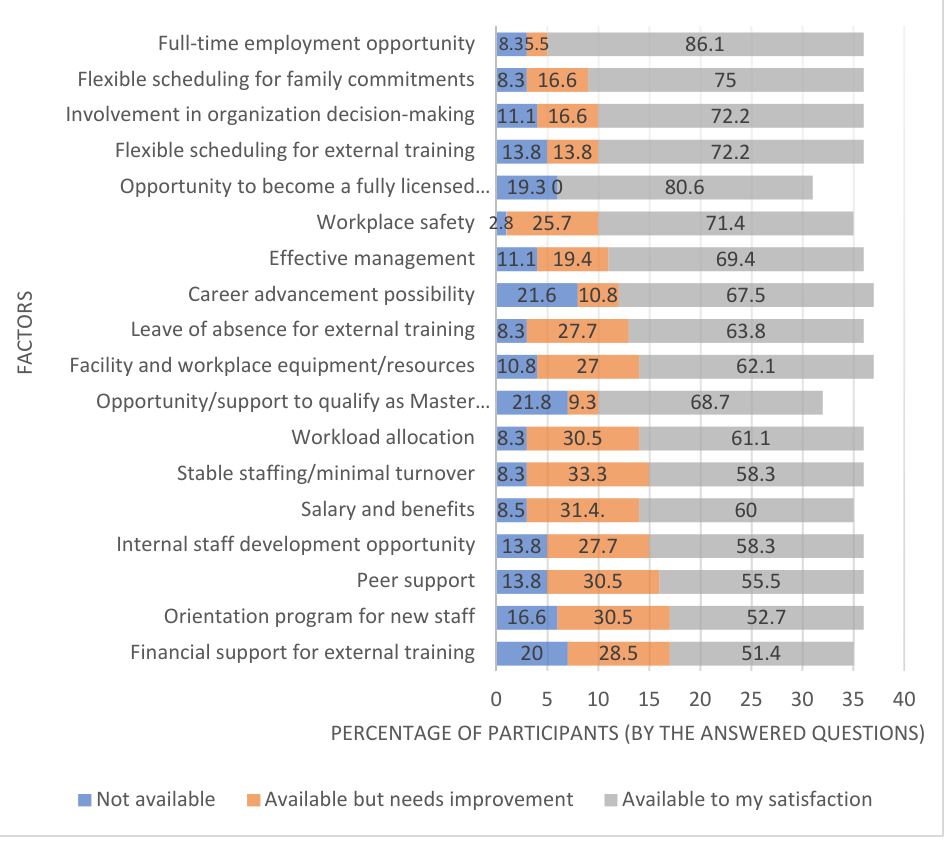
Figure 2. Availability and satisfaction with the following factors in the current workplace.